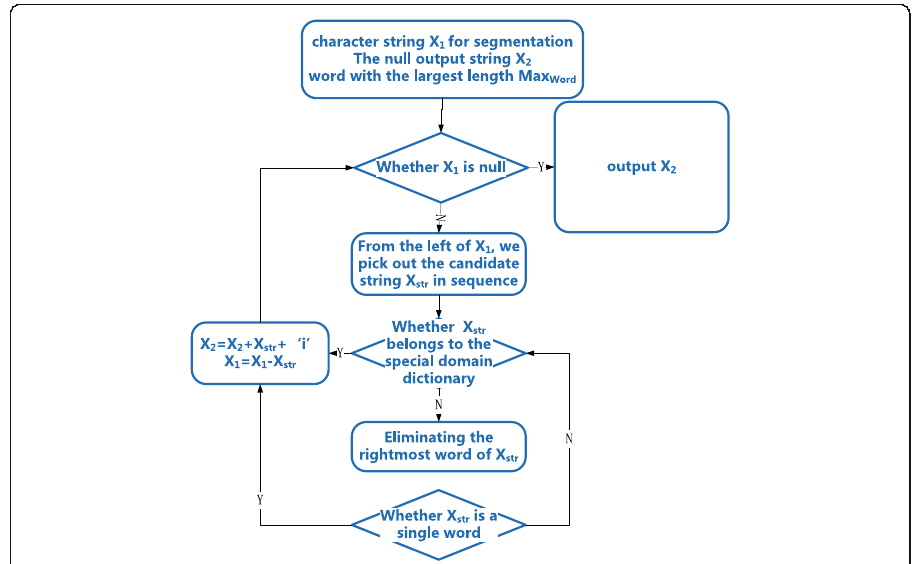
Fig. 3 Text segmentation approach based on the reverse maximum matching algorithm and radar domain